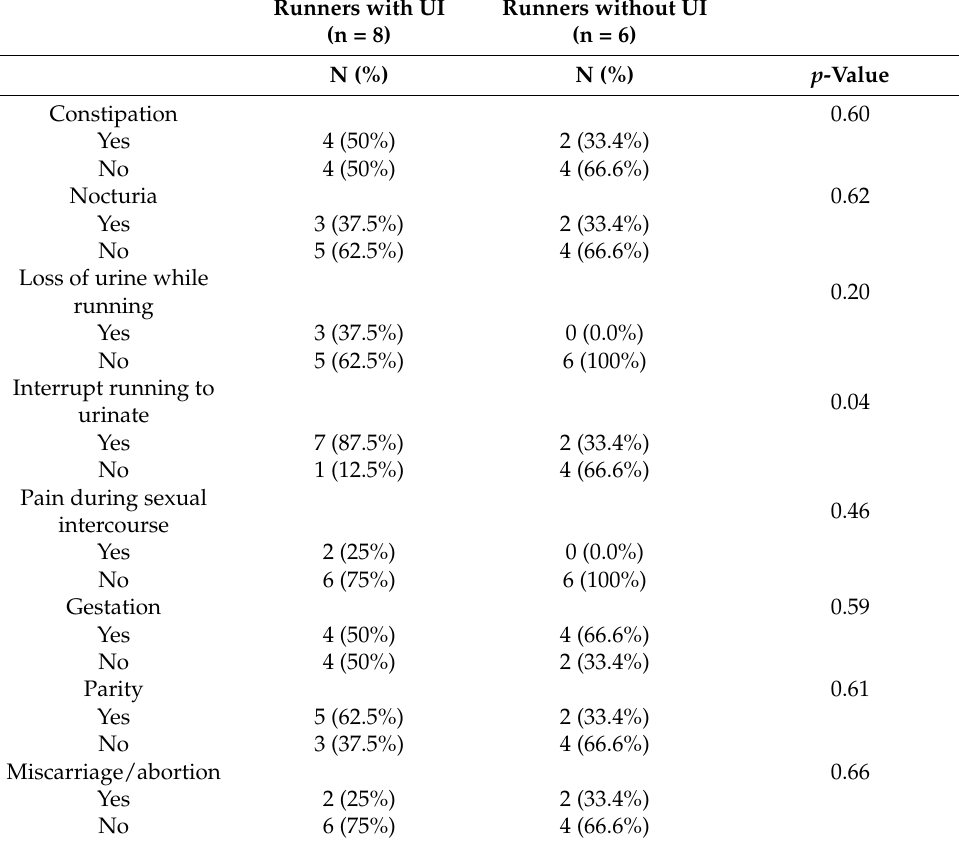
Table 2. Comorbidities, urinary symptoms and gynecological-obstetric characteristics of women half-marathon runners with and without urinary incontinence (n = 14). Pernambuco, Brazil, 2022. Runners with UI Runners without UI (n = 8)